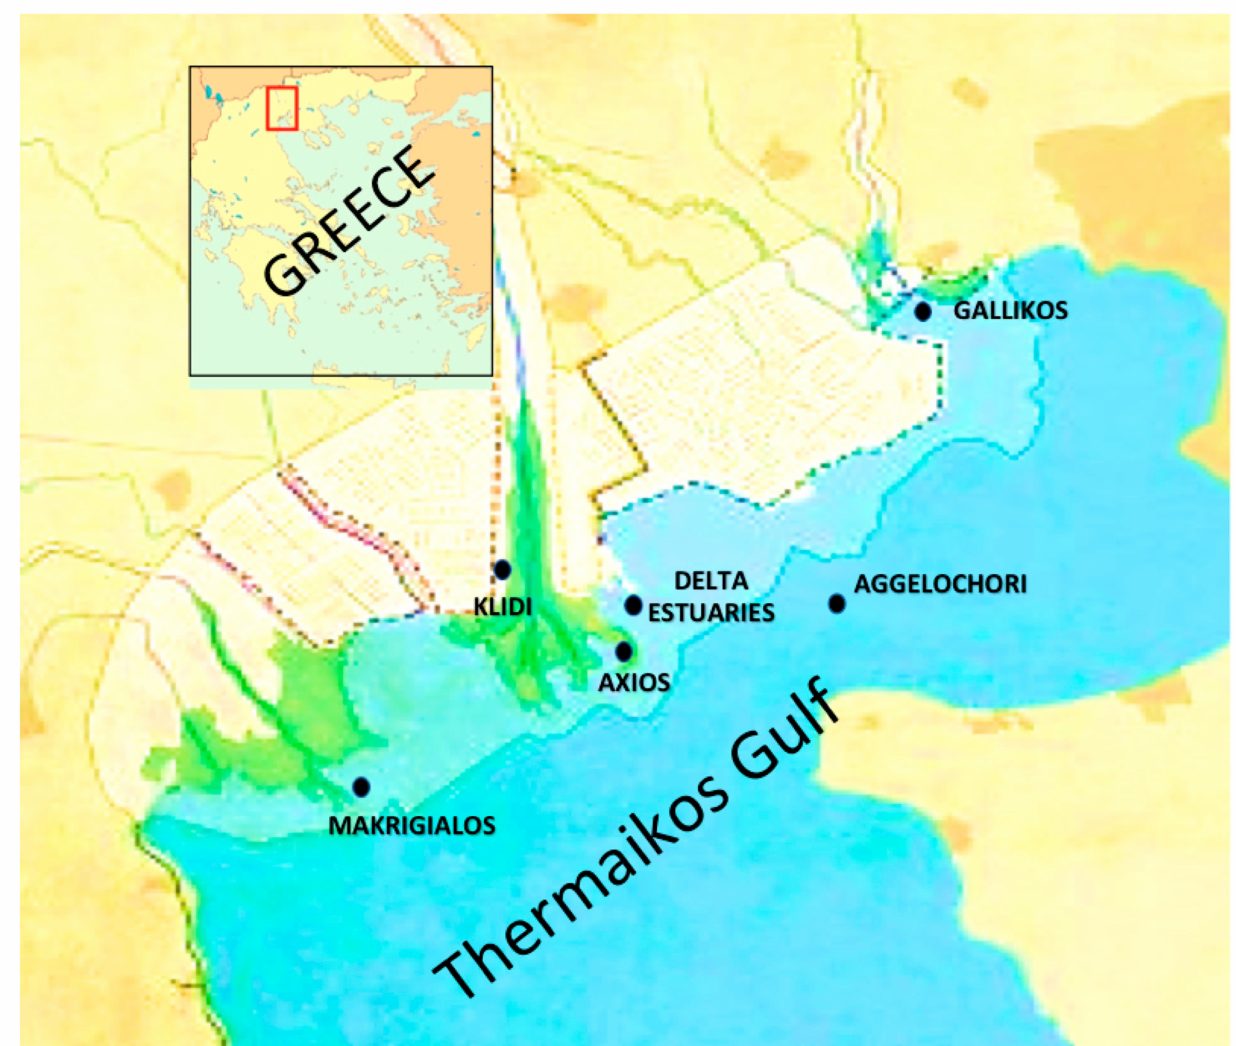
Figure 1. Sampling sites in Thermaikos gulf